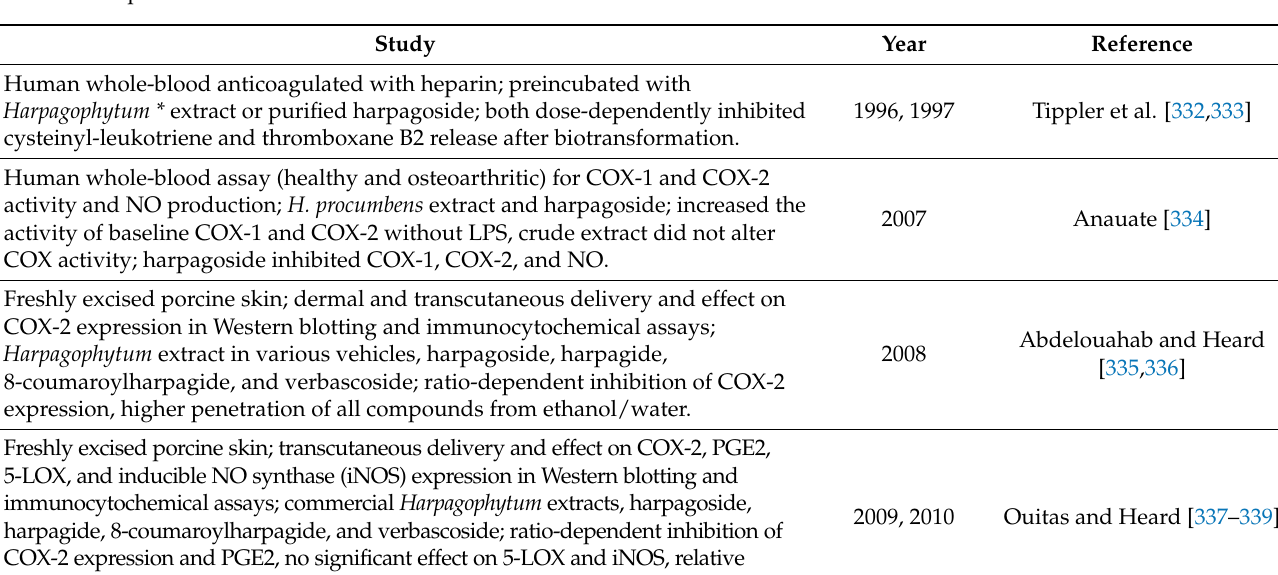
Table 6. Ex vivo experiments regarding analgesic/antinociceptive and anti-inflammatory effects of devil’s claw preparations and